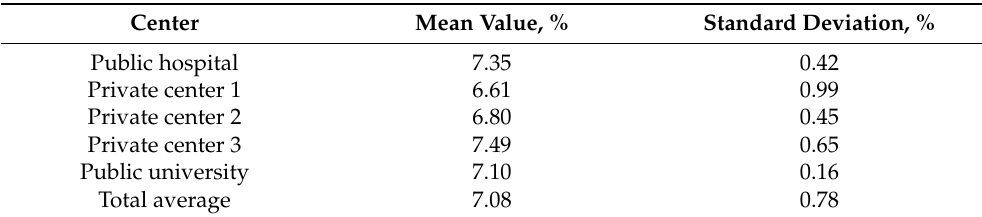
Table 1. Comparison of the mean values and standard deviations of HbA1c measured in different institutions.